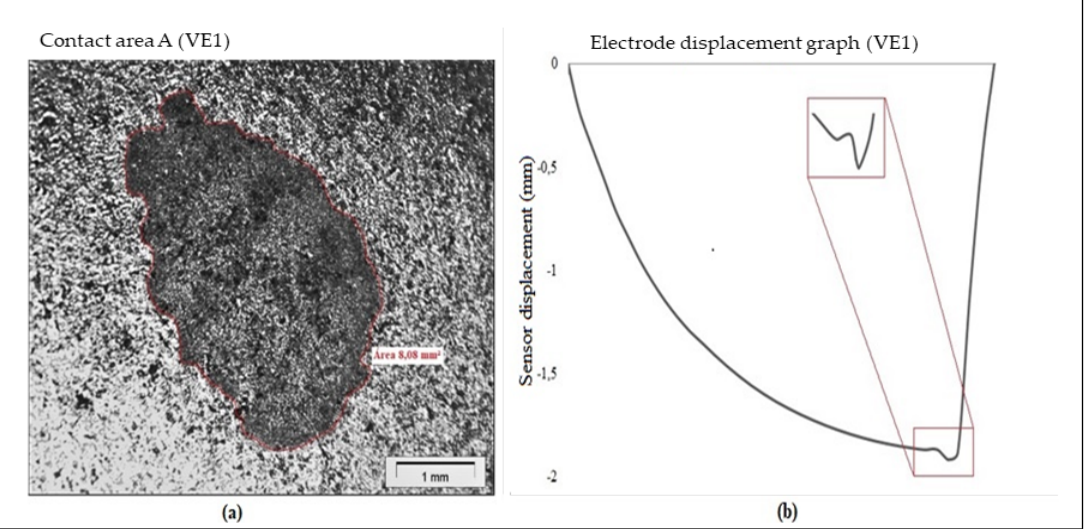
Figure 11. ( a ) contact area A of the first validation experiment; ( b ) electrode displacement graph of the first validation experiment. first validation